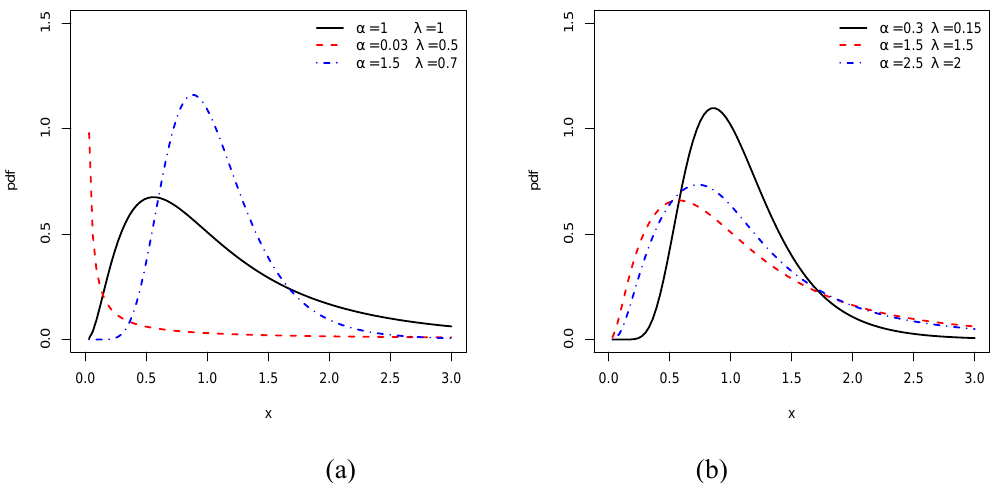
Figure 1 - Plots of the LONPC density for some values of λ and α .